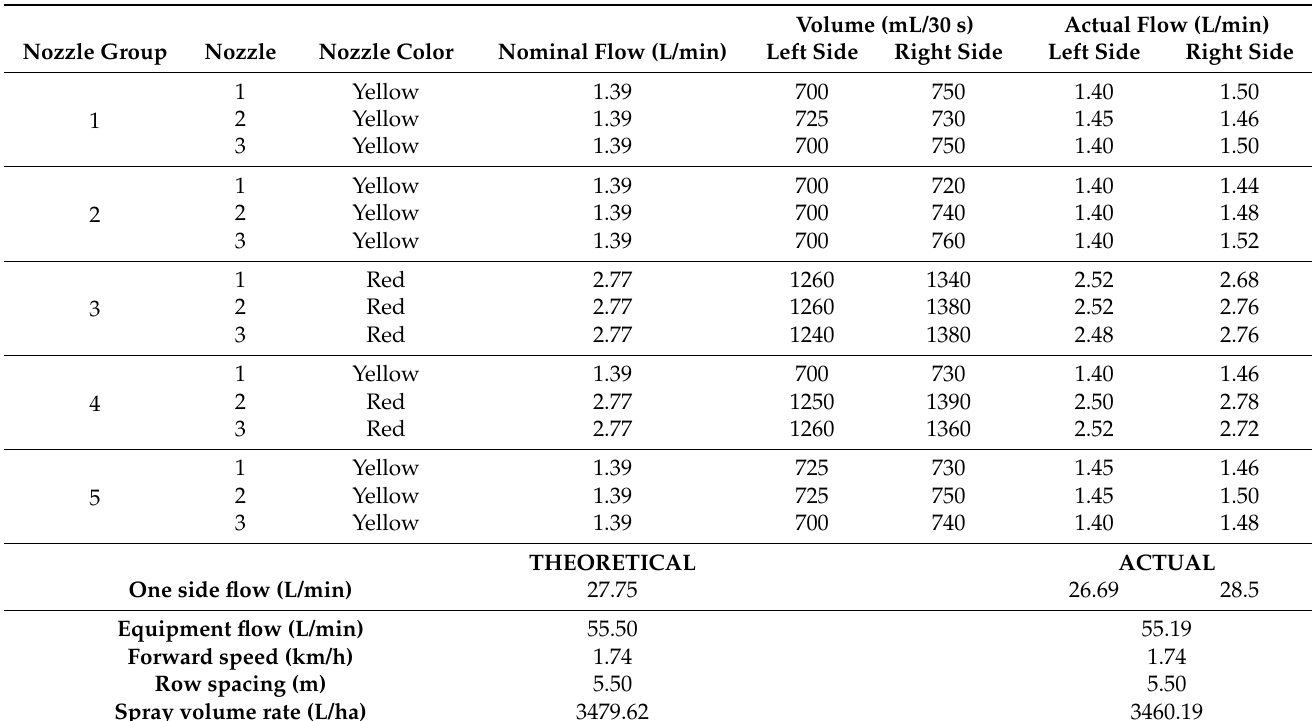
Table A8. Selection and calibration of nozzles for the T sprayer, with the following configuration: No adjusted to the vegetation/High & Low fan speed/High spray volume rate/Drift-reducing nozzles (Coarse)/Pressure: 9